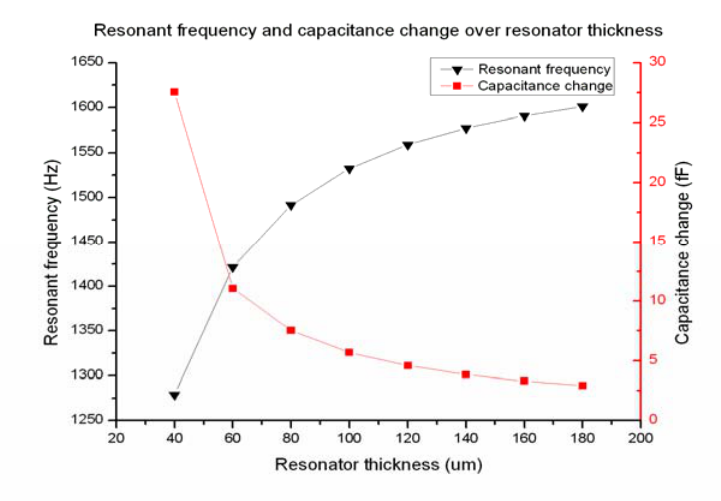
Figure 9. Resonant frequency and Δ C output over resonator